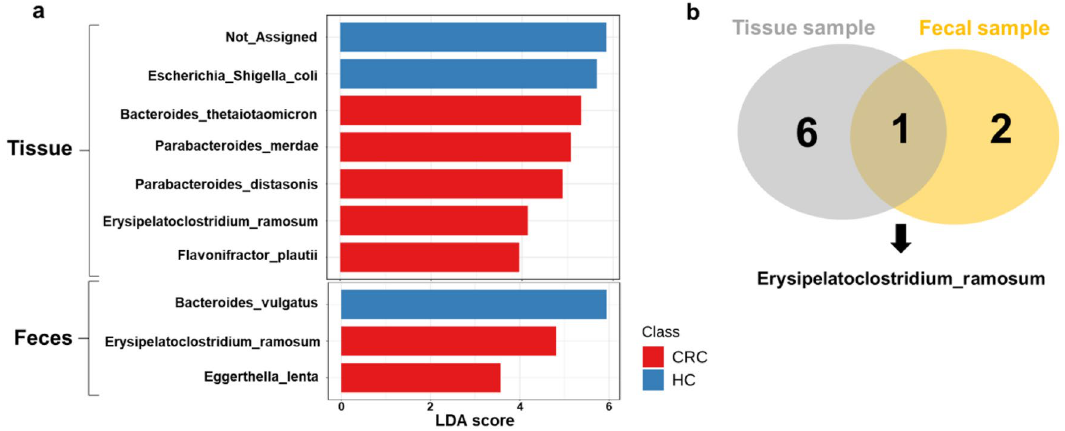
Figure 5. Linear discriminant analysis (LDA) effect size (LEfSe) analysis of mucosa (tissue) and lumen (feces)– associated microbiota among healthy control (HC), adenoma (AD), and colorectal cancer (CRC) groups, ( a ) Histogram of the LDA scores for significantly abundant species, ( b ) Venn diagram represented the number of unique and overlapping significantly abundant